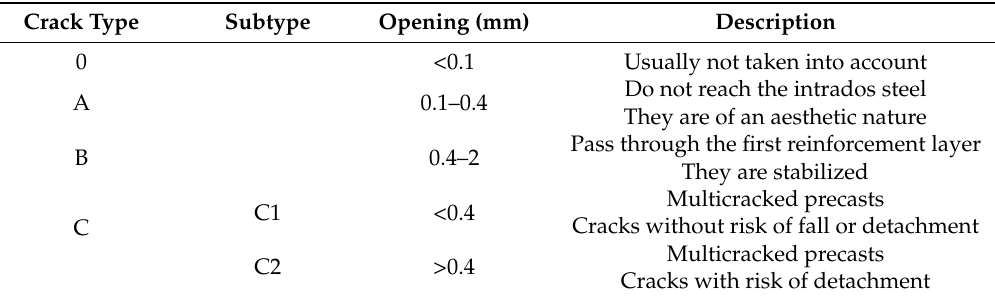
Table 2. Crack classification on tunnels.